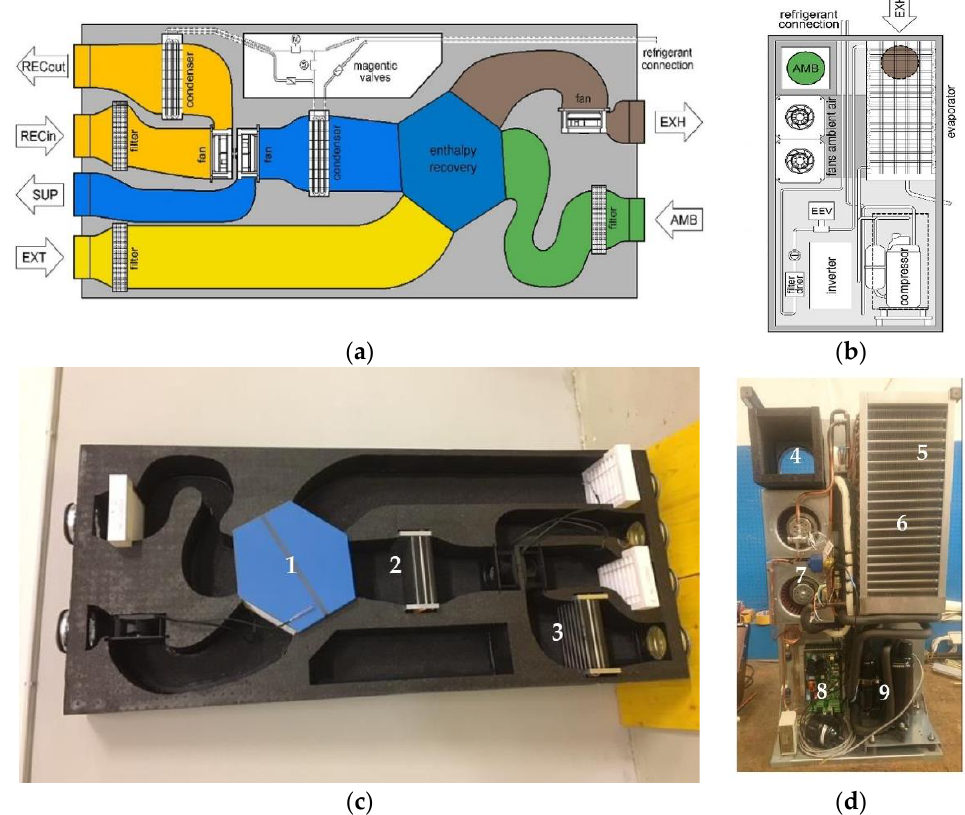
Figure 19. Scheme of the indoor unit with MVHR, condenser, and desuperheater as well as sound absorbers ( a ) and outdoor unit with evaporator, compressor, and inverter ( b ) of the developed functional model of an exhaust-air to supply-air heat pump with recirculation air, see also Ref. [11]. ( c , d ) photos of the indoor and outdoor unit, respectively. (1) HRV/ERV; (2) condenser (supply air); (3) condenser/desuperheater; (secondary air); (4) fresh air; (5) exhaust air; (6) evaporator; (7) radial fans; (8) inverter; (9) compressor.